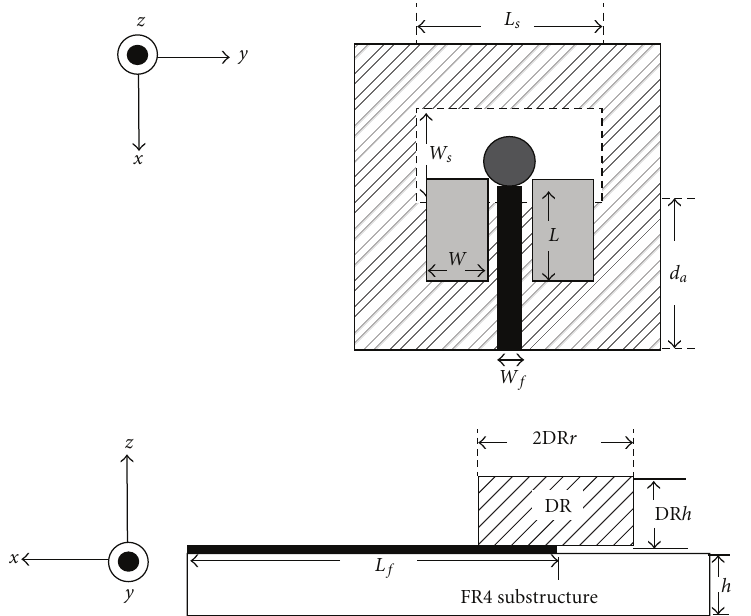
Figure 1: Configuration of hybrid DR antenna consisted of a rectangular slot, a cylindrical high-permittivity DR, and two-rectangular parasitic